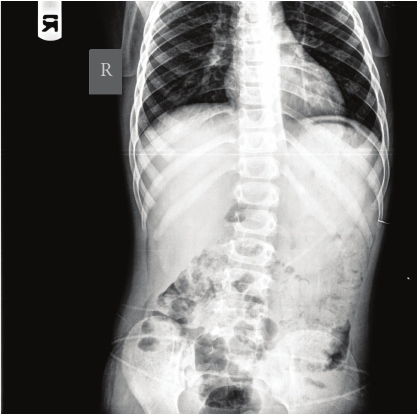
Figure 2: Flat upright X-ray that shows normal chest and scoliosis in thoracolumbar